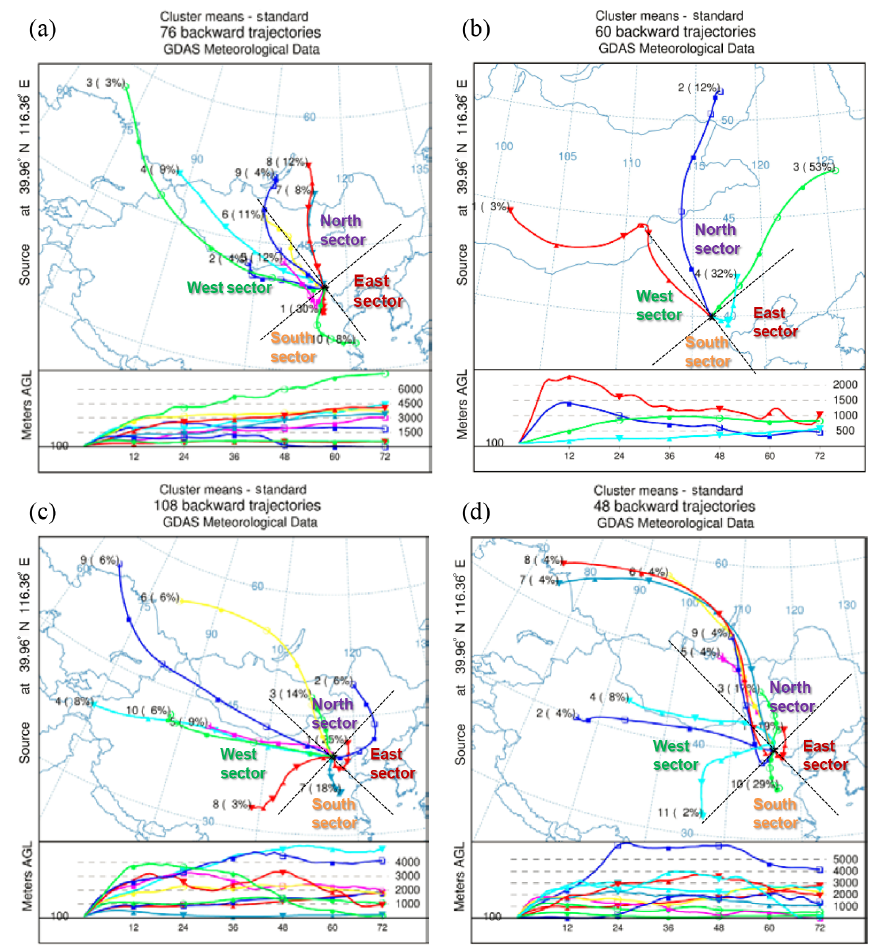
Figure 10. Seventy-two-hour backward trajectories for 100ma.g.l. (above ground level) in Beijing during the pre-Parade Blue period (1 to 19 August 2015) (a) , the Parade Blue period (20 August to 3 September 2015) (b) , and the post-Parade Blue period (4 to 30 Septem- ber 2015) (c) and for sampling duration of NH 3 (8 to 19 September 2015) in the post-Parade Blue period (d) .